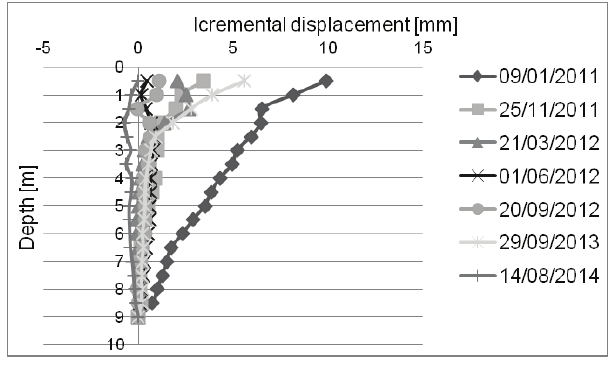
Fig. 5. Displacements from inclinometer measurements over time, measurement point I3